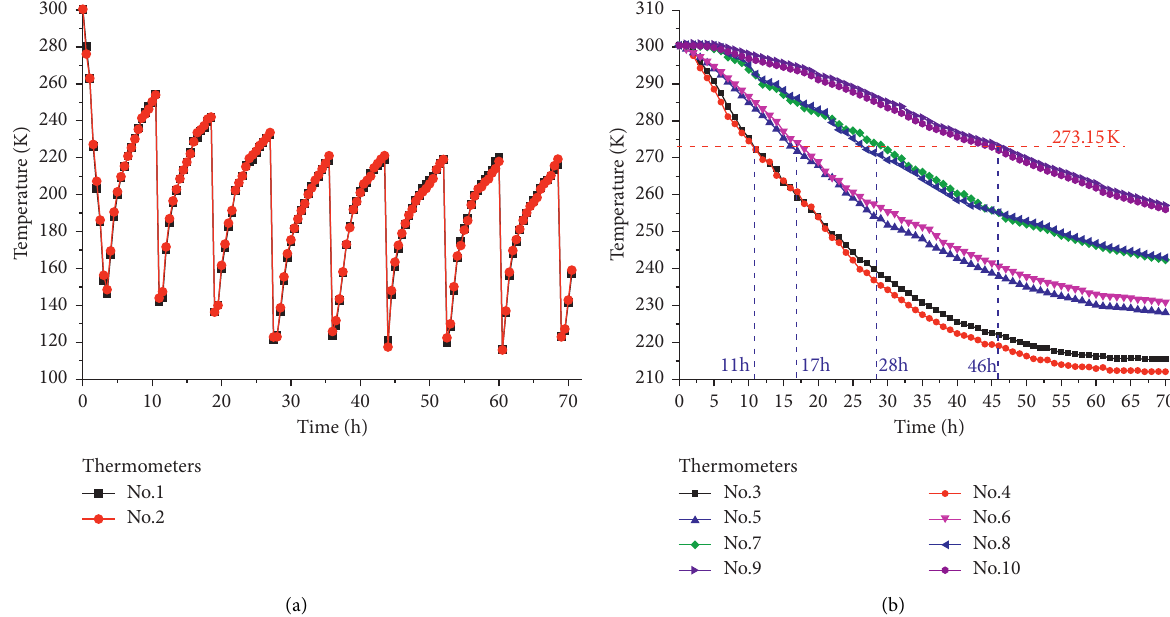
Figure 3: Temperature change in different positions in coal. (a) Test temperatures of No.1 and No. 2 thermometers. (b) Test temperatures of No. 3 ∼ No. 10